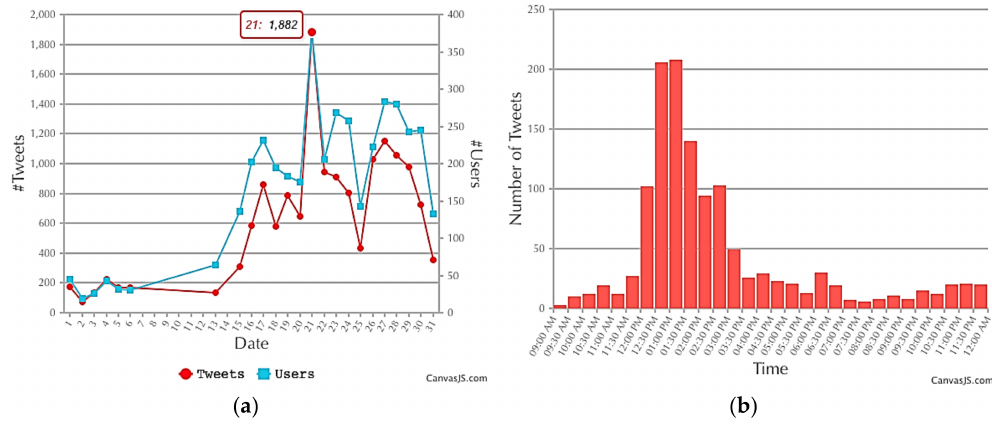
Figure 4. Number of tweets and users in January 2014 ( a ) and the hourly pattern on 21 January ( b ) in West Lafayette.